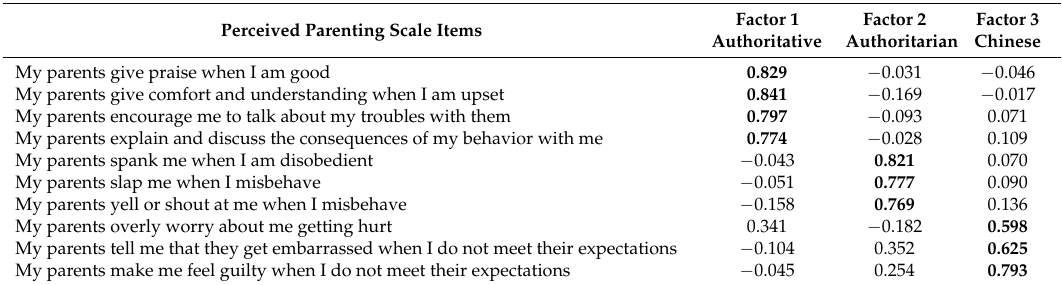
Table 1. Factor loadings with varimax rotation of each item in the perceived parenting